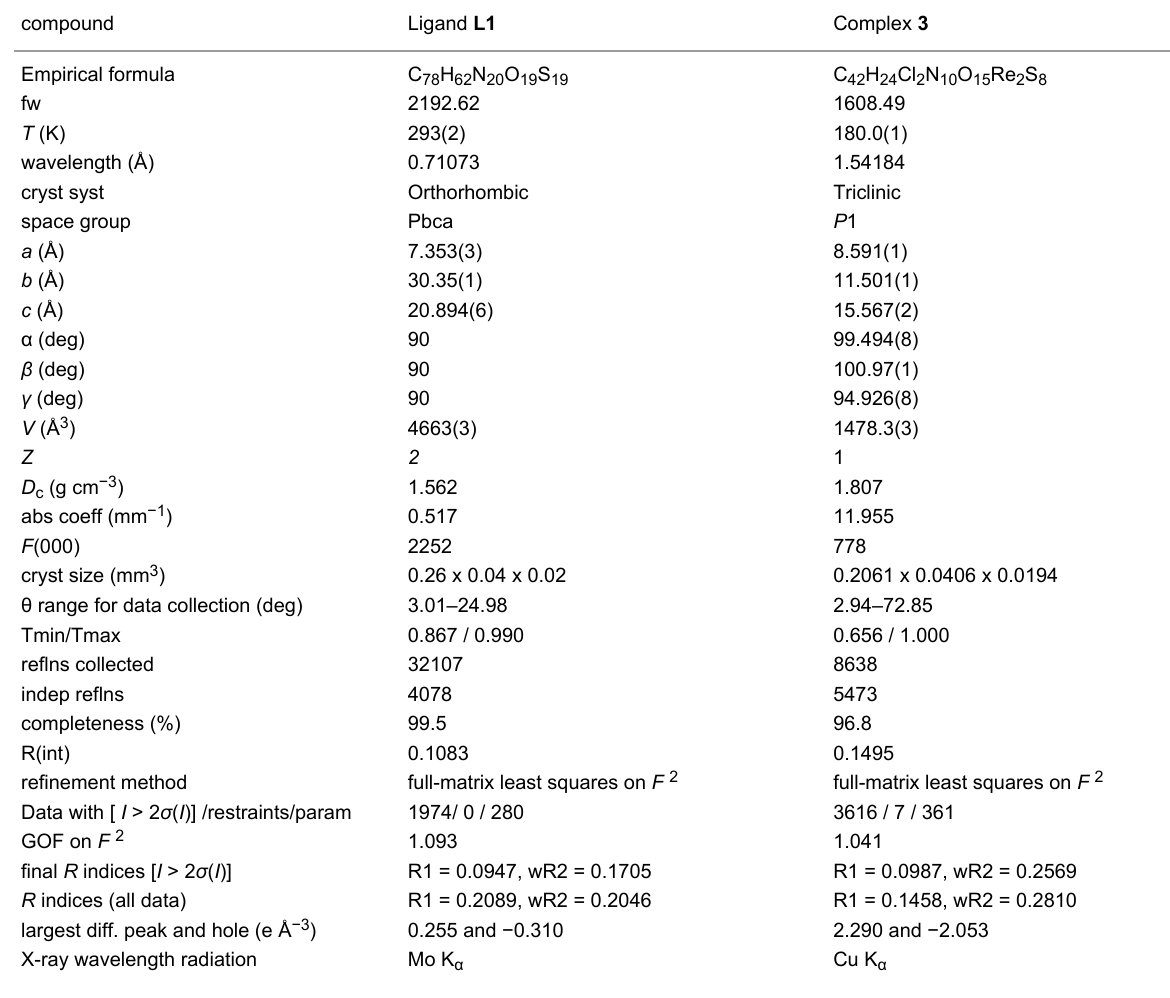
Table 1: Crystal data and structure refinement for ligand L1 and complex 3